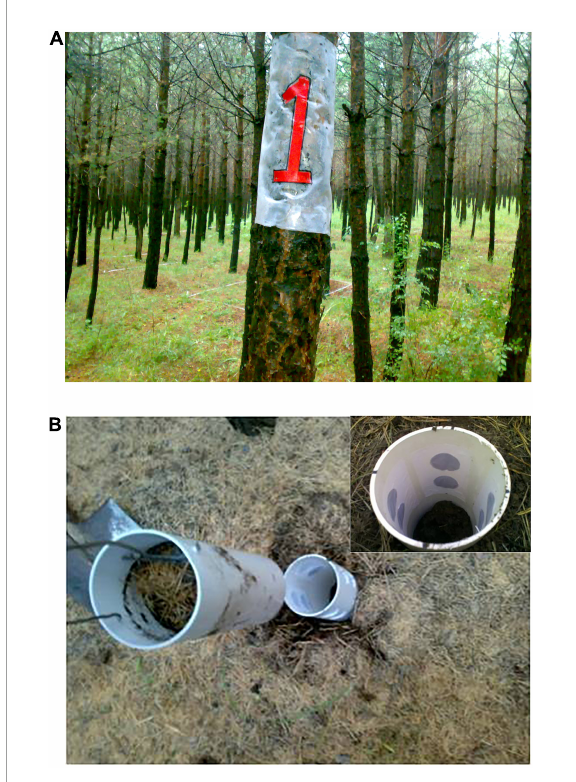
FIGURE2 Nitrogen fertilization plots and installation of the mesh collar tubes. (A) The 20 m × 20 m plots were established with four levels of N fertilization. Each level has three replicate plots. Fertilization began in 2009 and conducted three times a year since then. (B) In each plot, there were four pairs of T tubes and M tubes for soil respiration measurement and two pairs for PLFA assay. The M tube is a 30 cm long PVC tube with eight circular windows (2.5 cm diameter) drilled in the upper 10 cm of the tube. Windows were covered with nylon frame in a 40- µ m mesh size (insert image). To install an M tube, a T tube was first installed. After 2 months, the T tube and its inside soil core were lifted. The M tube was inserted into the resulting hole, and the intact soil core was refilled. Respiration was measured 2 years after tube